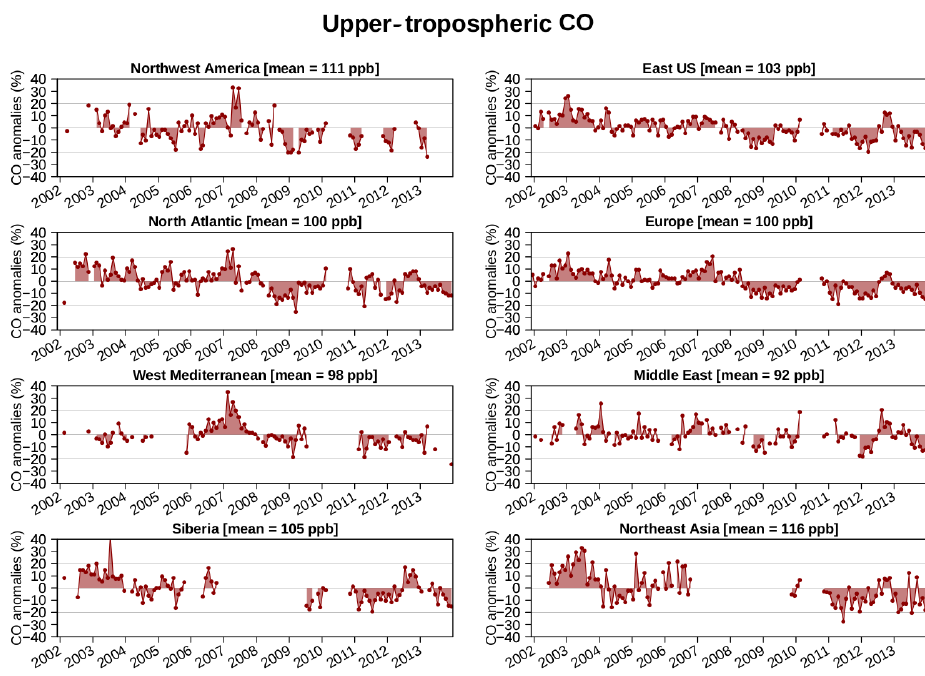
Figure C3. Relative monthly anomalies of CO volume mixing ratio in the upper troposphere. The units % refer to the corresponding climatological means indicated above each graph.